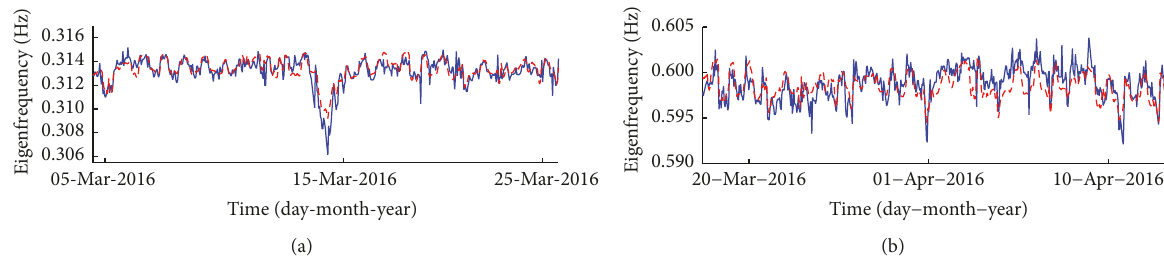
Figure 15: Trend of experimental (blue solid curves) and reconstructed (red dashed curves) eigenfrequencies: first eigenfrequency (a) and third eigenfrequency (b).